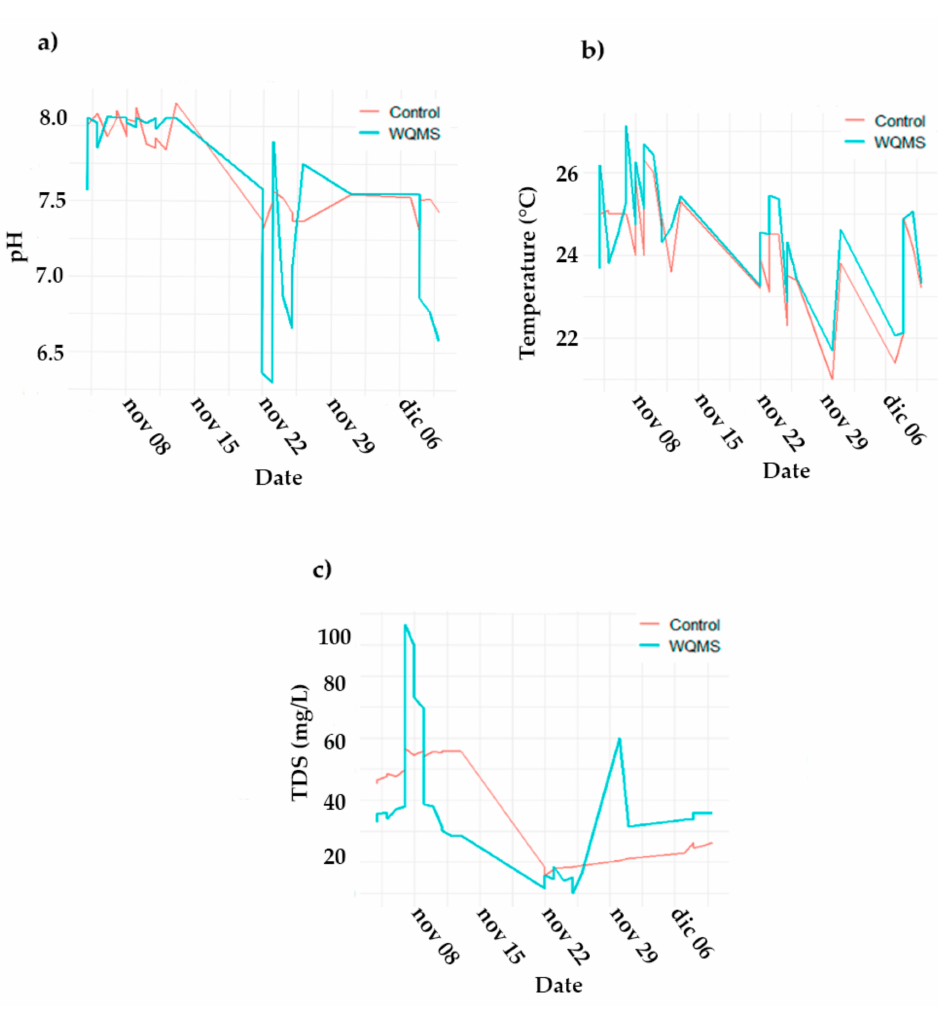
Figure 5. Validation of IoT-WQSM sensors, ( a ) pH, ( b ) temperature, and ( c ) total dissolved solids (TDS).